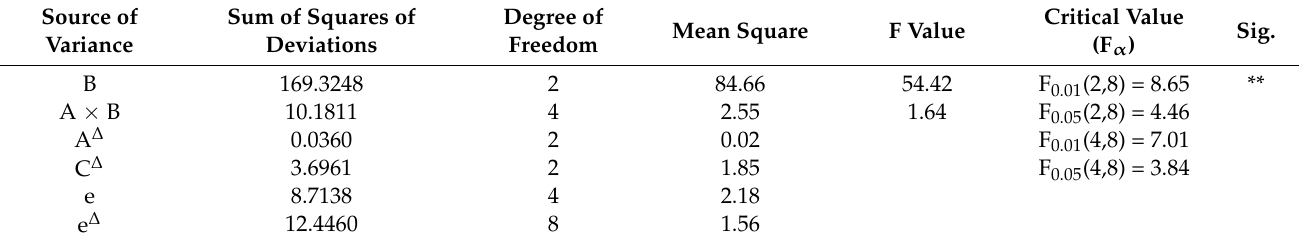
Table 4. Variance analysis.